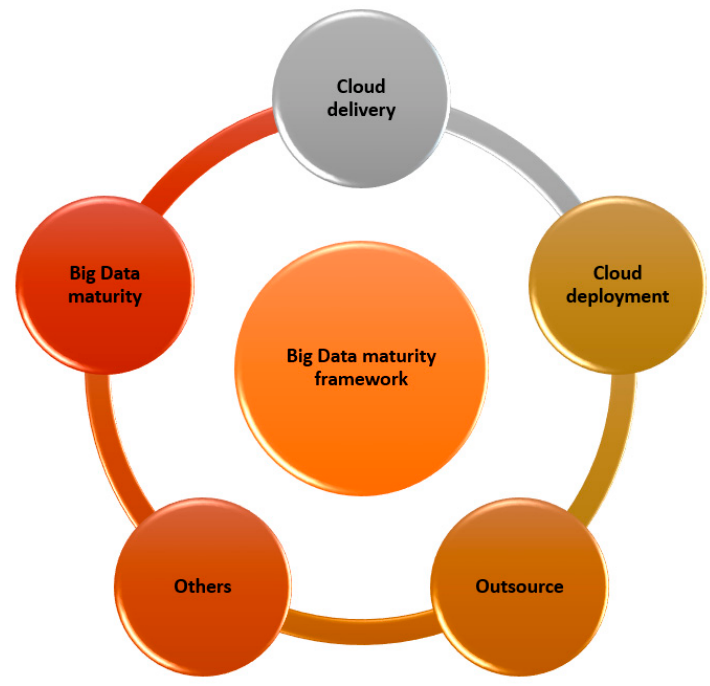
Figure 8. The other dimensions of the TDWI Maturity Model.